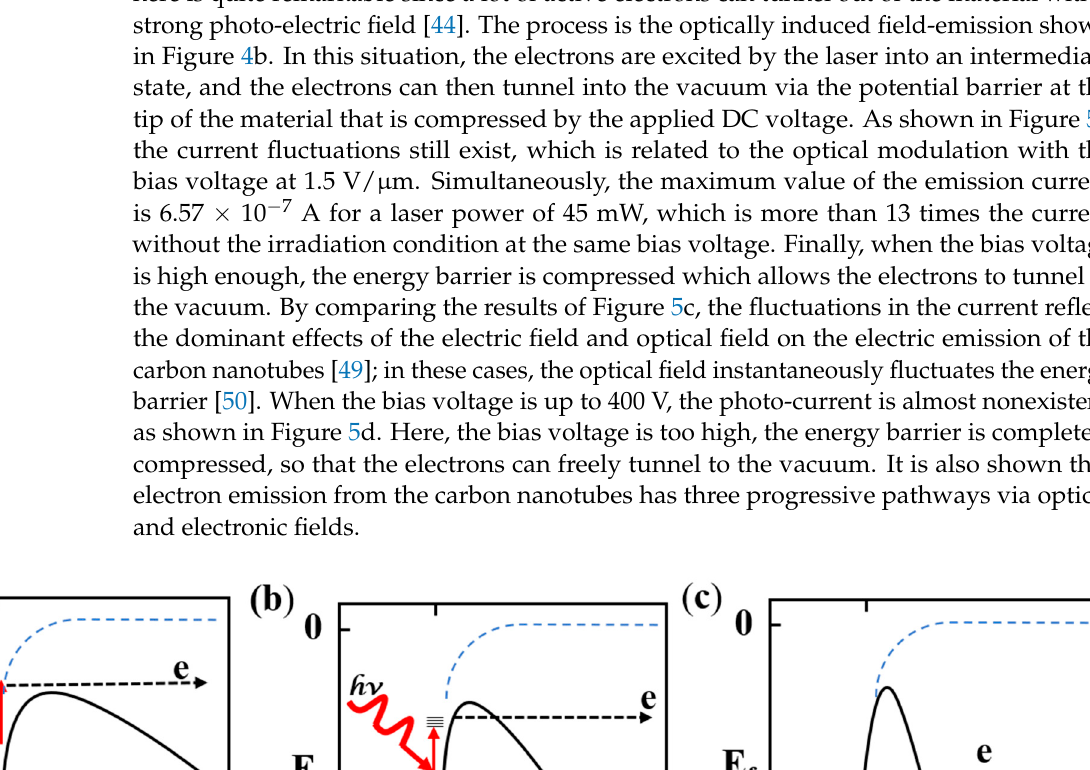
Figure 5. The variation of emission current of the VCNTAs under the different laser power and bias voltage, when the laser is switched on and off. Different colors in each figure represent different excitation laser power, ( a ) at a bias of 100 V, ( b ) at a bias of 200 V, ( c ) at a bias of 300 V, and ( d ) at a bias of 400 V. The stability test is shown in Figure 6a. For a bias voltage of 300 V and a laser power of 45 mW, the emission current was 2.3 × 10 − 7 A and the emission variability of the cathode of VCNTs was less than 2% during the 2400 s. With the irradiation time prolonged, the emission current appeared to fluctuate increasingly, the current fluctuations were ex- tended further (the average current increased). The light excitation was stopped at 1200 s, as shown in Figure 6c. This is because the fs-laser peak power density is too high and the